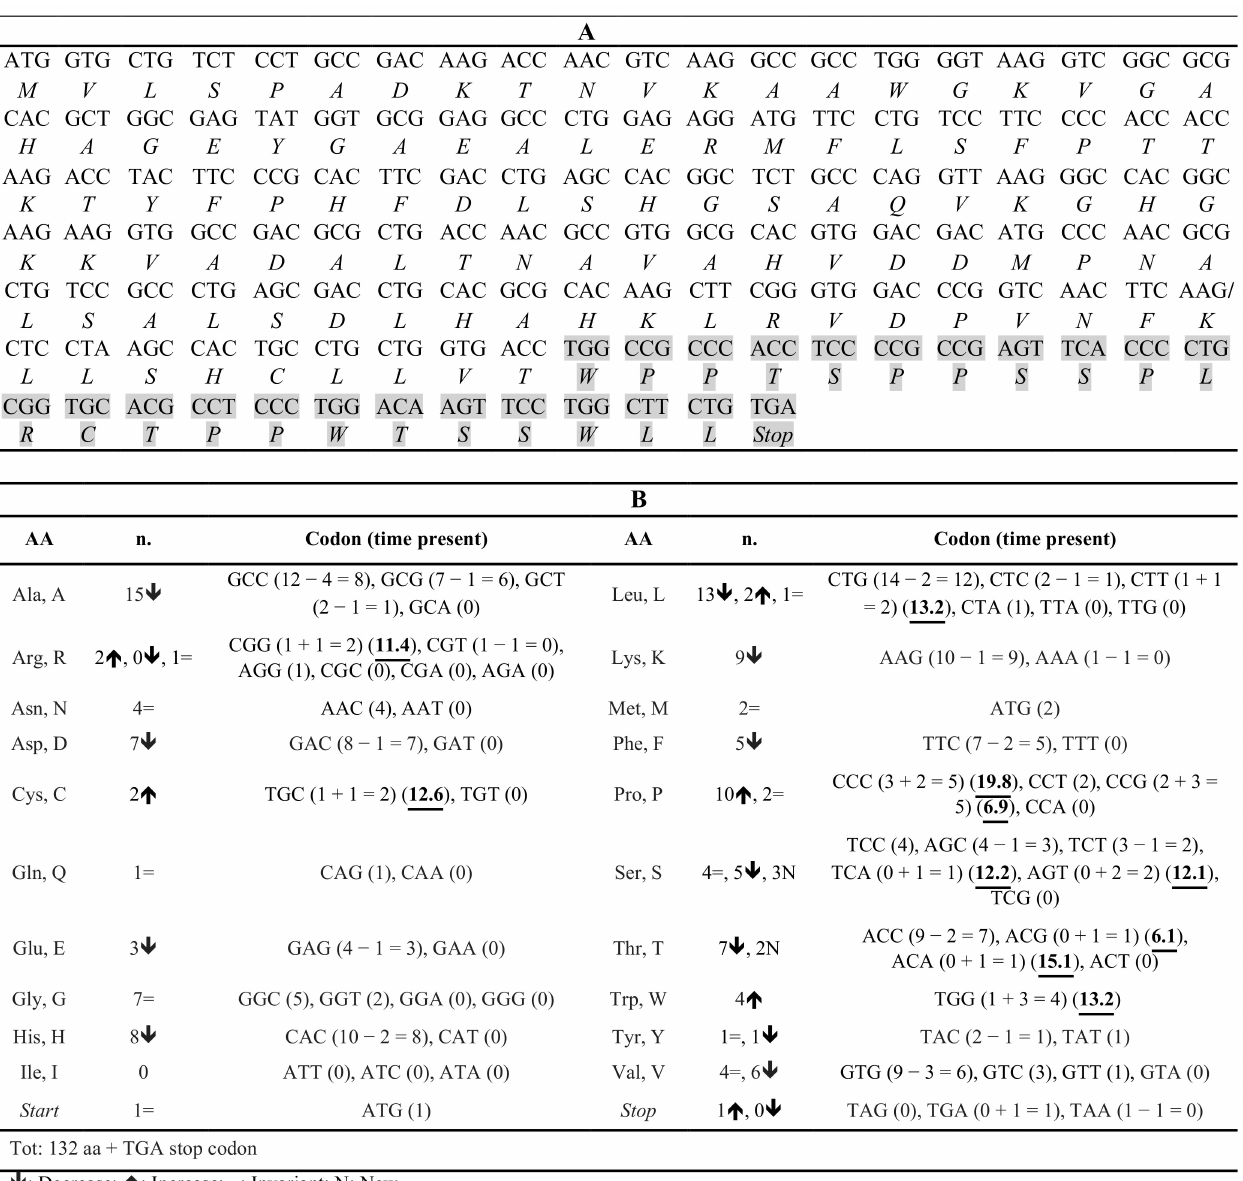
Figure 7. ( A ) Nucleotide triplets coding the Hb Sciacca mRNA, from the ATG to the stop codon at position 132; below, the corresponding amino acids present in this α -globin chain variant. The changes in Hb Sciacca amino acids (aa) following the frameshift from cod109 are marked in gray. The symbol/indicates the position of the exon2/3 boundary. ( B ) Types of aa present in the Hb Sciacca α -globin chain, the corresponding coding triplet, and the number of occurrences in the Hb Sciacca mRNA. The numbers underlined and in bold indicate the codon usage